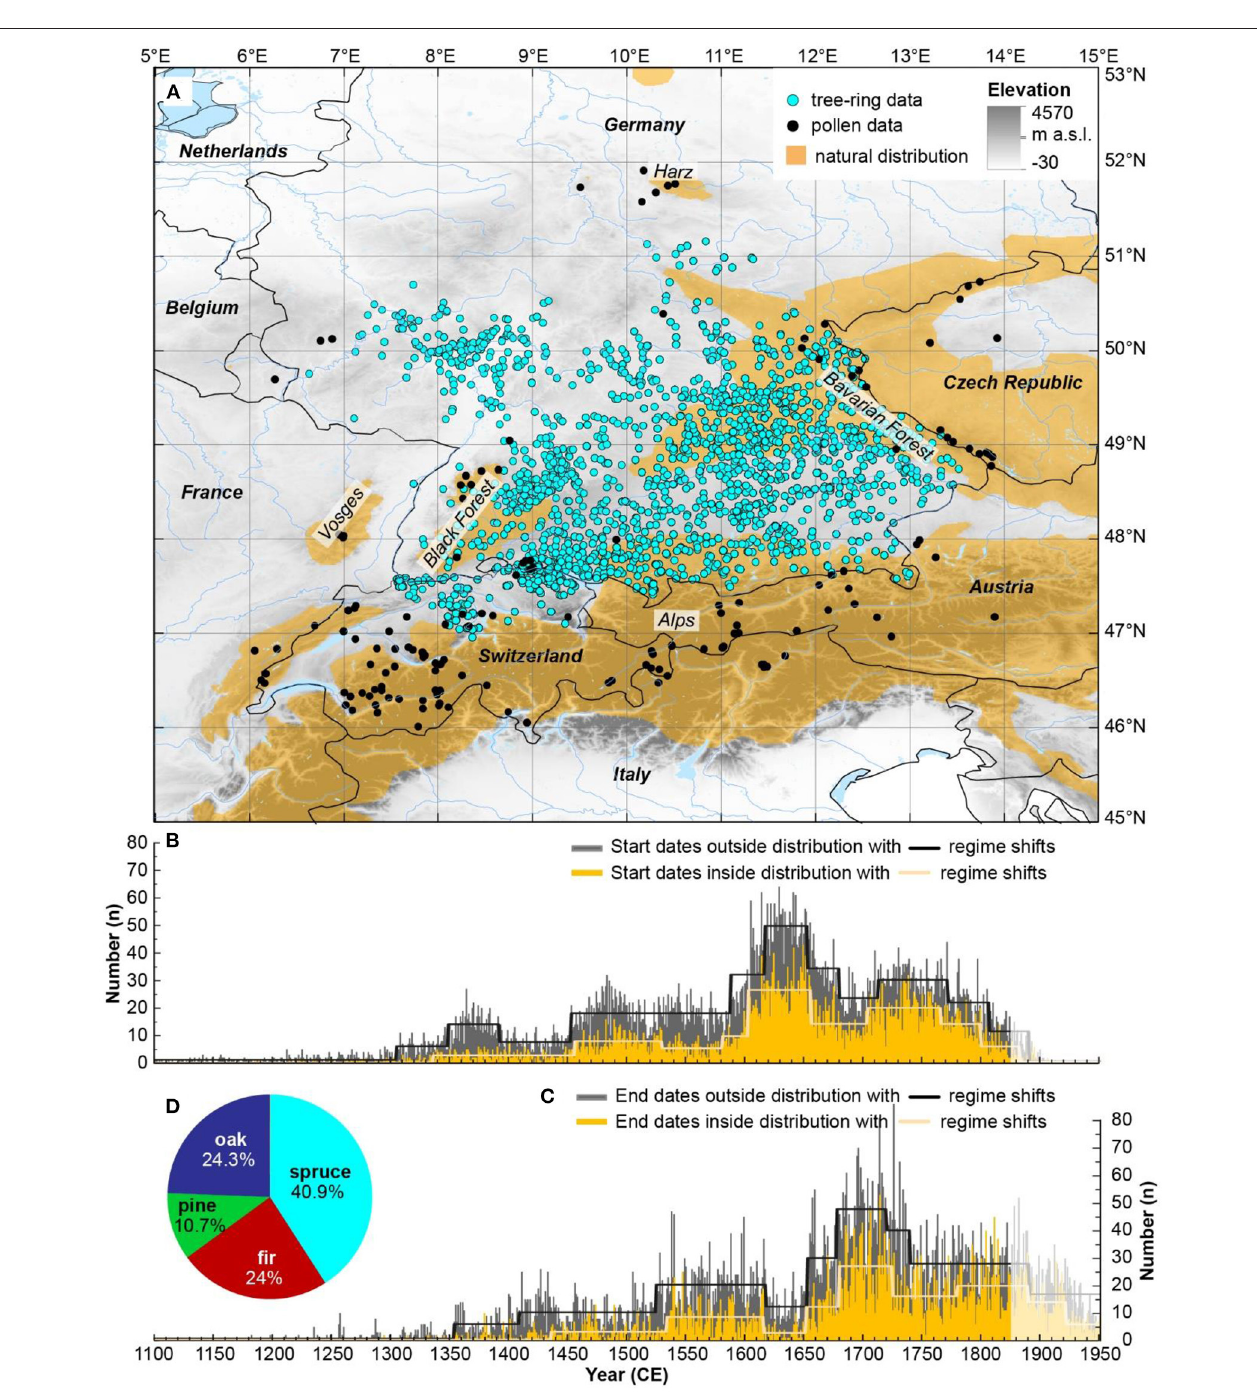
FIGURE 1 | (A) Location of spruce tree-ring (turquois dots) and pollen data (black dots) used in this study. The elevation map (see legend for color) is superimposed by the natural distribution of Norway spruce ( Picea abies ) (orange areas) (source: http://www.euforgen.org/species/picea-abies/). (B) Start dates and (C) end dates with significant shifts in their temporal distribution (regime shifts) from historical spruce timber for the region within (orange bars, yellow line) and outside (gray bars, black line) the natural distribution of spruce. (D) Main tree species used as timber in constructions during the period 1150 – 1850. information of each timber. It has to be noted that the exact To investigate past forest structures and harvest times, location of the sampling within the stem is unknown in the mean tree age, the average growth rates (AGR), and historical mean tree diameter were calculated using the tree-ring width